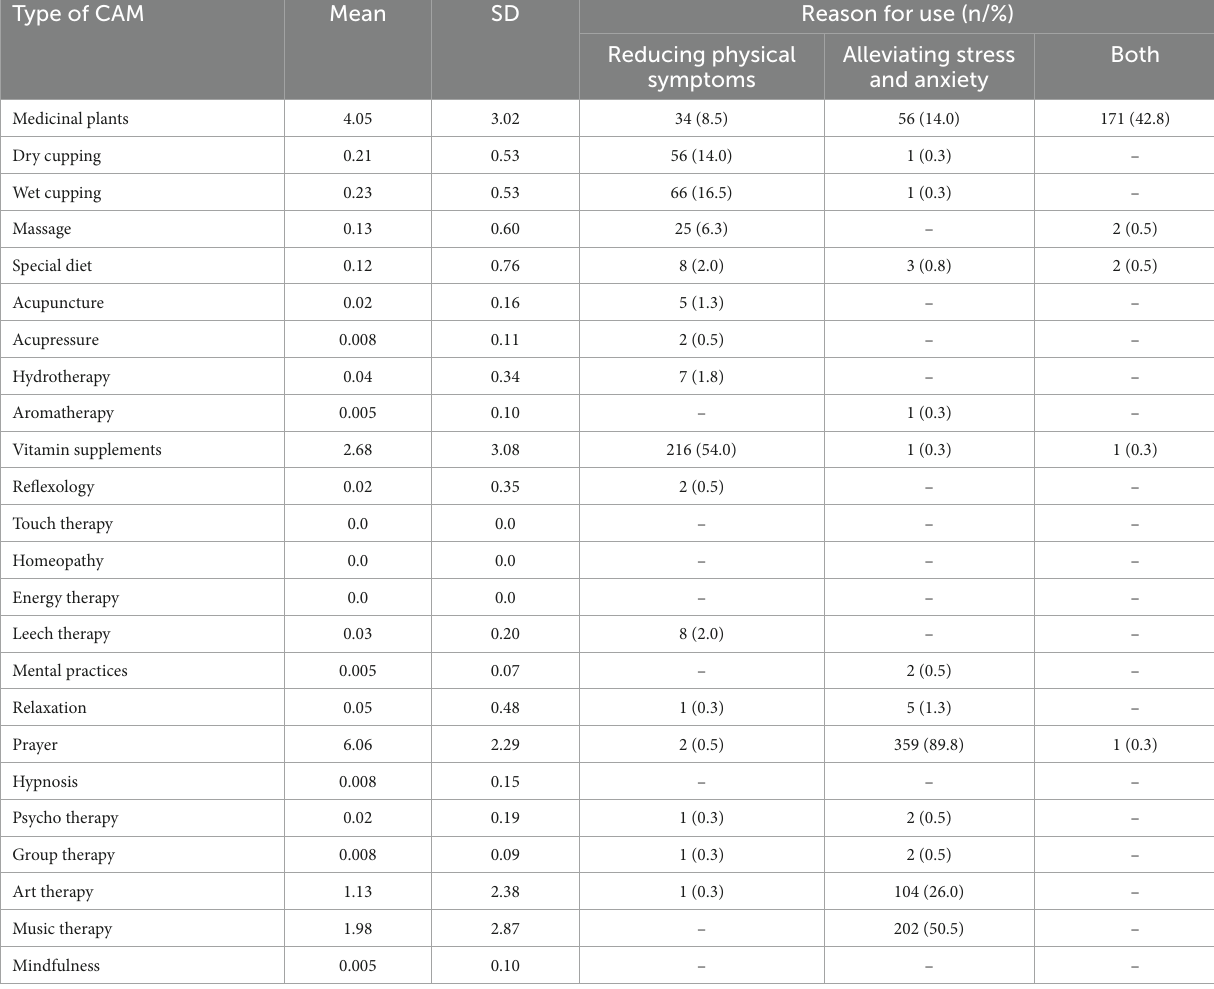
TABLE 2 Discription of the reasons for use of different types of complementary and alternative